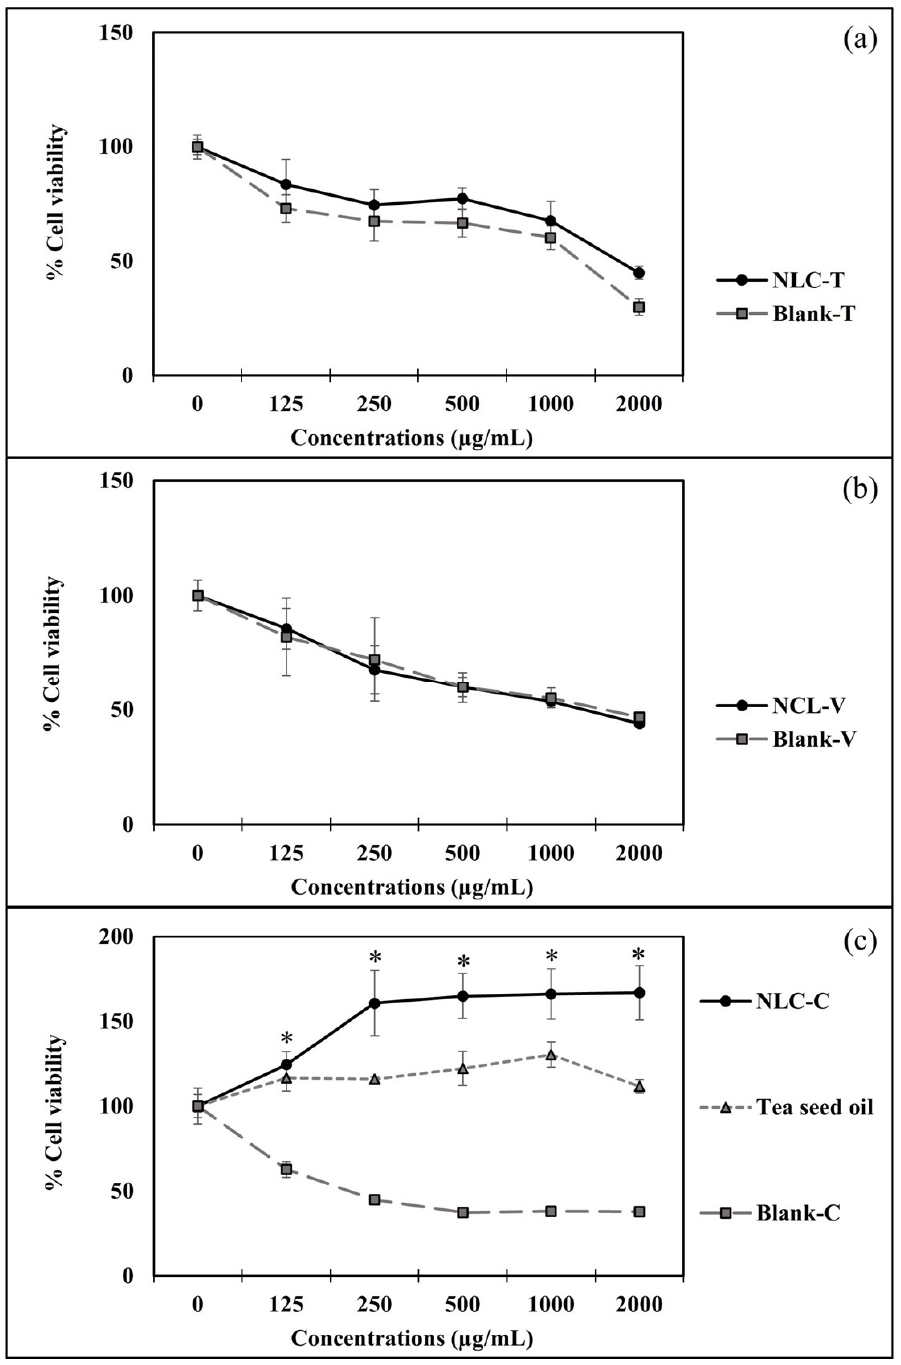
Figure 6. Percentage of cell viability of NLC-T and its blank ( a ), NLC-V and its blank ( b ), and NLC-C and its blank in comparison with tea seed oil ( c ) at the oil concentrations of 0, 125, 500, 1000, and 2000 µg/mL (* indicates statistical significance at P < 0.05).